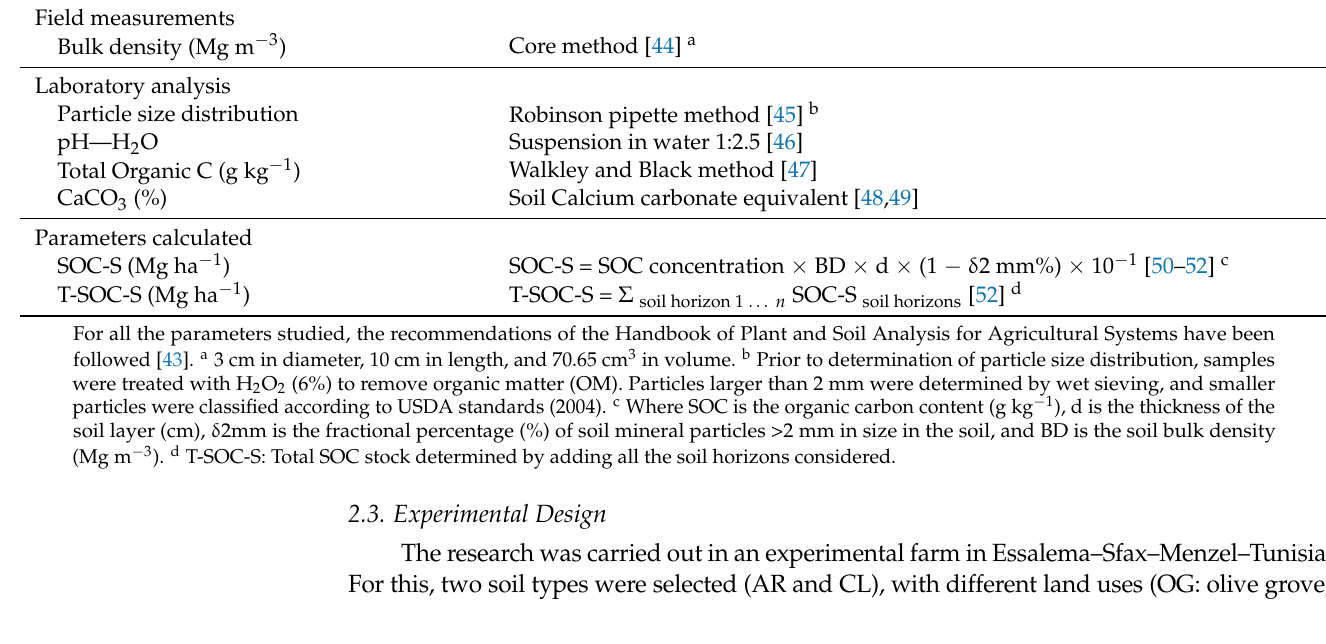
Table 1. Analytical methods used in this study (field measurements, laboratory analysis, and parameters calculated).